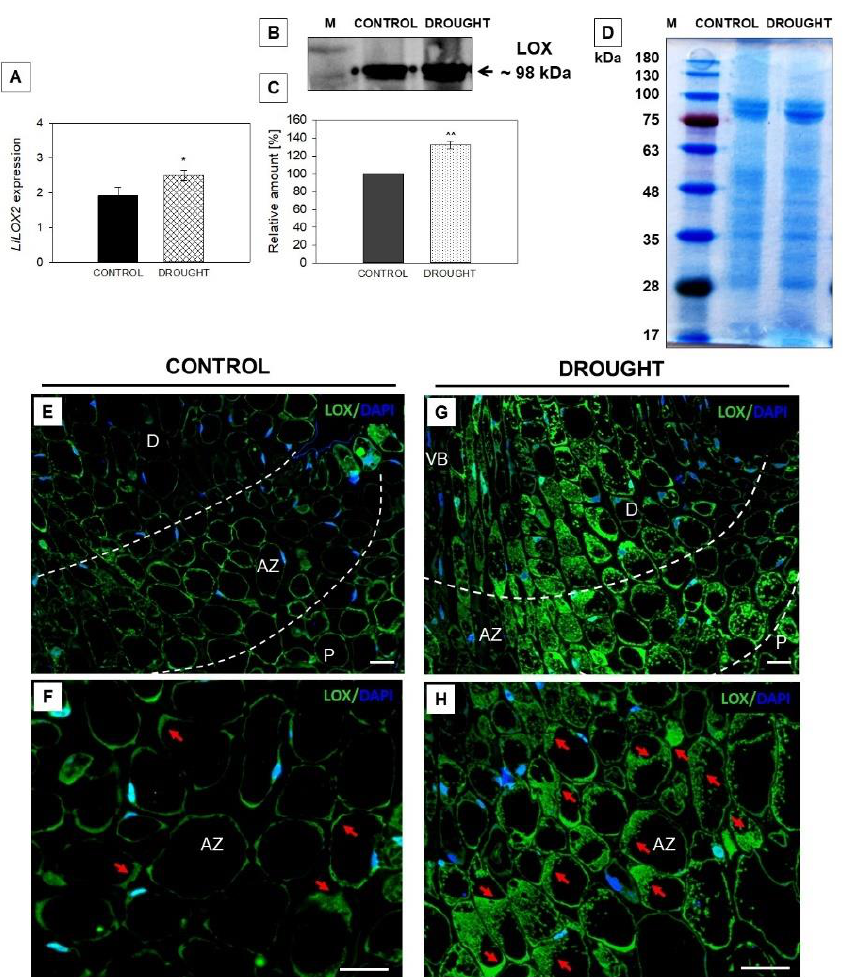
Figure 3. Lipoxygenase (LOX) is regulated by drought in the flower abscission zone (AZ) of Lupinus luteus . Analyses were carried out on flower AZs collected from 48 day-old lupines cultivated under drought (25% water holding capacity, WHC) or control (70% WHC) conditions. See Material and Methods for the details. Plant tissues were used for the expression analysis of LlLOX2 ( A ). Asterix indicates a significant difference with * p < 0.05. The isoform of LOX of ~98 kDa was obtained on the nitrocellulose membrane in the Western blot reaction with an anti-LOX antibody ( B ). A band was scanned and quantitative densitometric analysis was made ( C , 100% was set for the control). ^^ p < 0.01 indicates a significant difference. SDS-PAGE electrophoresis gel stained with Coomassie Brilliant Blue ( D ). Sizes of molecular mass marker (M) are shown in kDa. Immunodetection of LOX in the flower’ AZ of control ( E , F ) and drought-stressed ( G , H ) plants. Green fluorescence indicates LOX accumulation (marked by red arrows), while blue labeling corresponds to nuclei stained with DAPI. AZ area is marked by white dotted lines. Images F and H are magnified regions of AZ from control and stressed tissues. Abbreviations: AZ—abscission zone; D—distal region of AZ; P—proximal region of AZ; VB—vascular bundle. Bars = 40 µM.